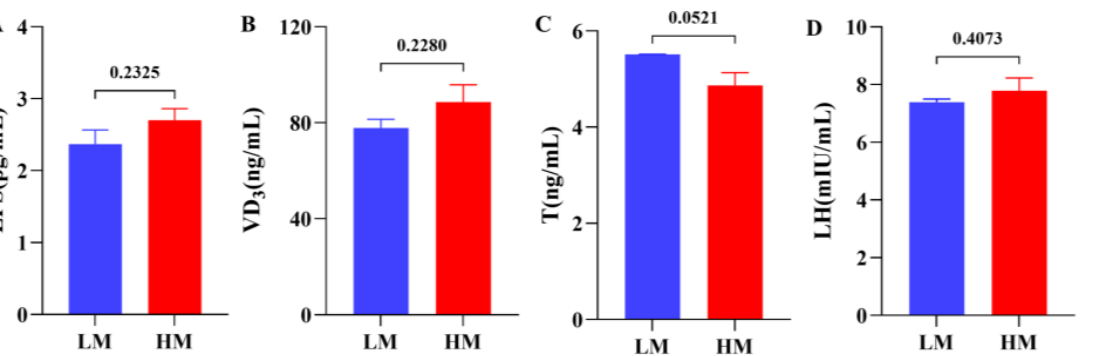
Figure 2. Serum physiological parameters between LM and HM groups: ( A ) LPS (lipopolysaccha- rides, pg/mL), ( B ) VD 3 (vitamin D3, ng/mL), ( C ) T (testosterone, ng/mL), ( D ) LH (luteinizing hor- mone, mIU/mL), ( E ) FSH (follicle-stimulating hormone, mIU/mL), ( F ) MT (melatonin, pg/mL), ( G ) GC (glucocorticoid, ng/mL). LM, low − motility group; HM, high − motility group. 3.3. Analysis of the Taxonomic Composition of the Bacterial Microbiota After sequencing eight samples, a total of 119,061 CCS sequences were obtained by barcode identification, yielding at least 13,756 CCS sequences per sample and an average of 14,883 CCS sequences. Subsequently, 48,735 final valid data points were obtained after removing the primers, chimeras, and denoising. The ACE, Simpson, and Shannon diver- sity indices showed no change in alpha diversity between HM and LM and, briefly, no significant change in species richness and diversity (Figure 3A – C, Supplementary Table S1). Figure 3. Alpha-diversity analysis of gut microbial community structure in LM and HM groups ( A ) ACE index: ( B ) Simpson index, ( C ) Shannon index. Red represents the HM group; blue represents the LM group. LM, low − motility group; HM, high − motility group. Subsequently, we further explored whether there were differences in gut microbial composition between HM and LM and found that the dominant microbial phylum in the rumen microbiota was Firmicutes, followed by Bacteroidetes, Synergistota, Verrucomi- crobiota, and Protebacteriota (Figure 4A). The Wilcoxon rank sum test showed (Figure 4B) that Firmicutes, Actinobacteriota, and Protebacteriota abundance was significantly higher in HM at the phylum level, whereas Bacteroidota and Synergistota were significantly higher in LM. The dominant microbial genus in the rumen microbiota was Prevotella ,